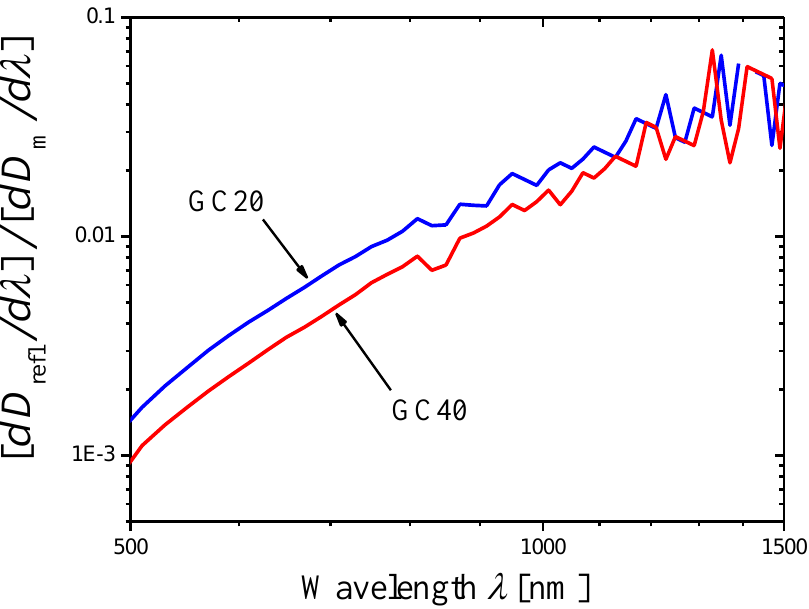
Figure 14. The ratio [ dD refl ( λ ) / d λ ] / [ dD m ( λ ) / d λ ] for the glass-ceramics GC20 and GC40. The wavelength step is ∆ λ = 20 nm .